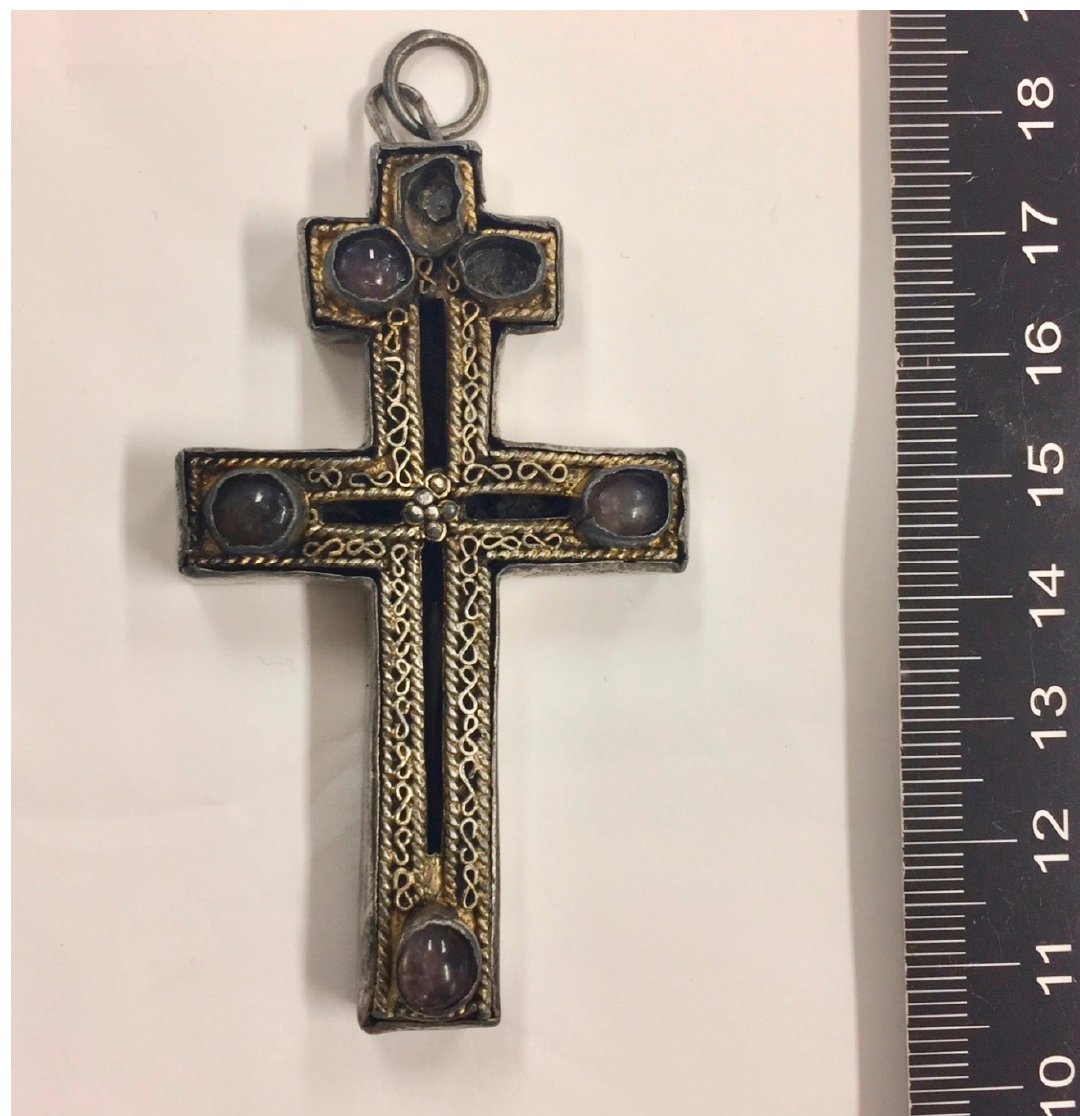
Figure 10. The Tønsberg cross. Silver and amethysts. H 7.1 cm. In the middle of the cross is an extant piece of wood. Photo: Kaja M. H. Hagen.